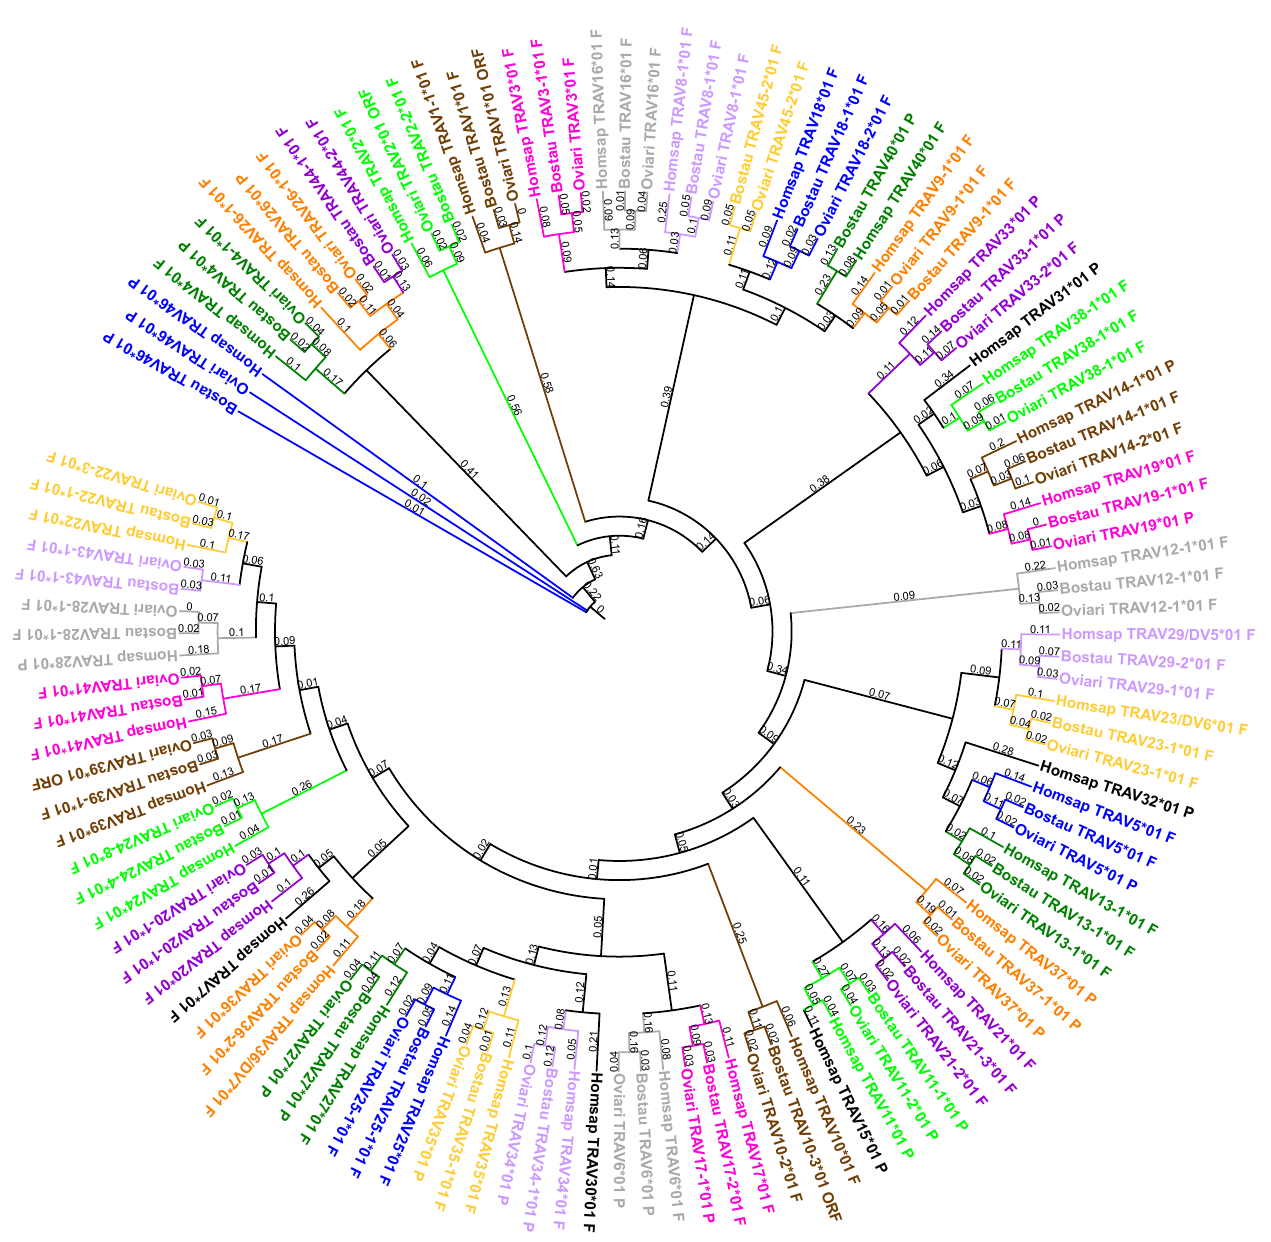
Figure 6. Phylogenetic tree of all TRAV subgroups for all species with one representative gene per subgroup (using V-REGION). Homsap: human, Bostau: bovine and Oviari: sheep. The different colors highlight the different subgroups. In black: subgroups only present in humans. Tree generated using NGPhylogeny.fr [25] (with MAFFT [26] and PhyML [27] programs) and iTOL v4